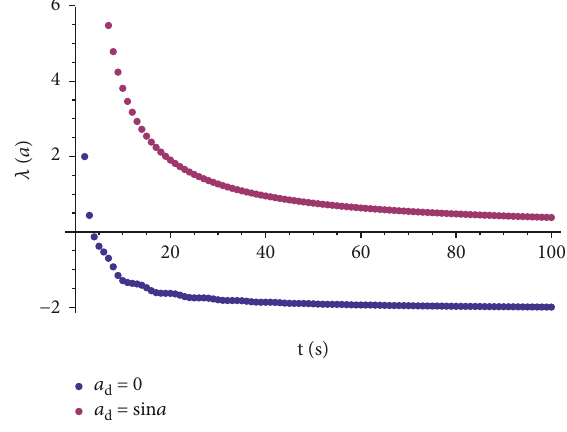
Figure 6: Lyapunov exponents of the joint angles under two conditions.